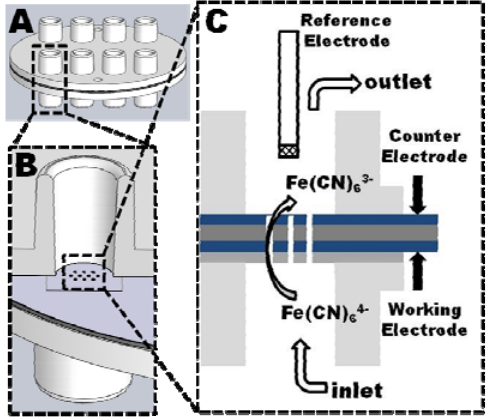
Figure 4. Electrochemical setup of the assembled device. ( A ) Schematic of the analysis device consisting of a polymer stack bonded between two polymer chips with through- holes for connection to pumps and potentiostats; ( B ) Cross section through a single analysis unit having 10 tubular microelectrodes in the polymer stack; ( C ) Electrochemical analysis uses a Ag|AgCl|3M NaCl reference electrode inserted into the upper through-hole, and tubing (not shown) connected to the lower and the upper through-hole as inlet and outlet, respectively. The tubular working electrodes and the planar counter electrode are electrically contacted by spring-loaded pins through neighboring through-holes.